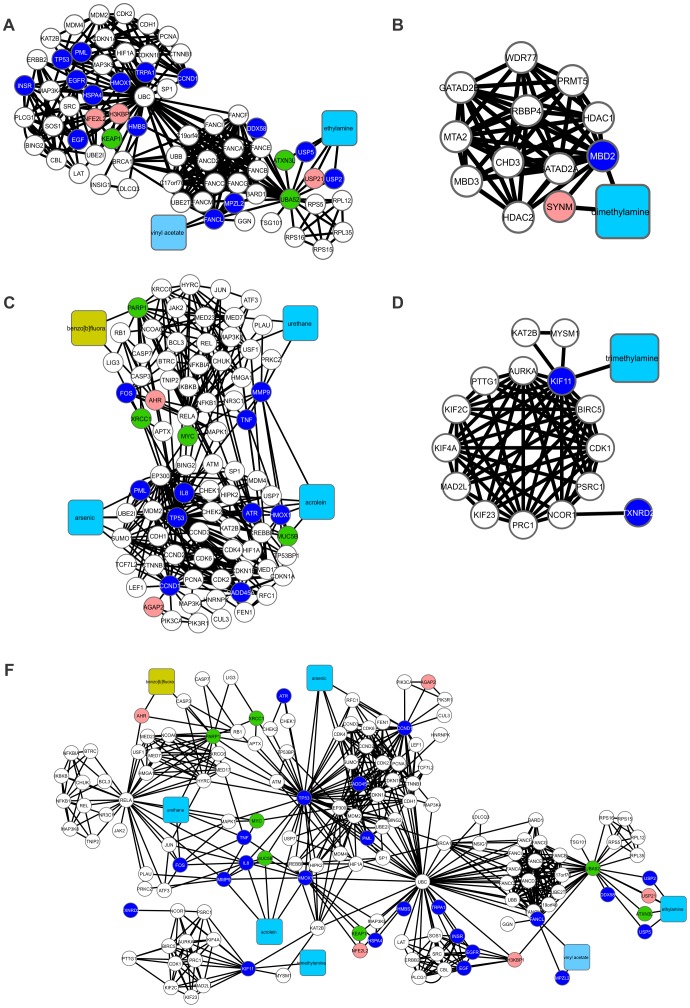
Subnetworks derived from the merge of clusters 5, 8 and 9.In (A), Cluster 5 is composed of 69 nodes and 315 edges, with Ci = 4,565. The associated hydrophilic components are vinyl acetate and ethylamine. Related GO terms: response to DNA-damage stimulus and cell cycle. cluster 7 (B) is composed of 13 nodes and 54 edges with Ci = 4,154. The associated hydrophilic compound is dimethylamine. Related GO term: chromatin organization. Cluster 8 (C) is composed of 85 nodes and 338 edges with Ci = 3,976. The associated lipophilic constituents are acrolein and benzo[b]fluoranthene, whereas the hydrophilic constituents are urethane and arsenic. Related GO terms: DNA-damage stimulus and regulation of cell cycle. Cluster 9 (D) is composed of 16 nodes and 58 edges, with Ci = 3,625. The hydrophilic constituent present is trimethylamine. Related GO term: cell cycle processes. The union of clusters 5, 8 and 9 (F). Clusters 7 did not show any proteins overlapping with any other cluster.